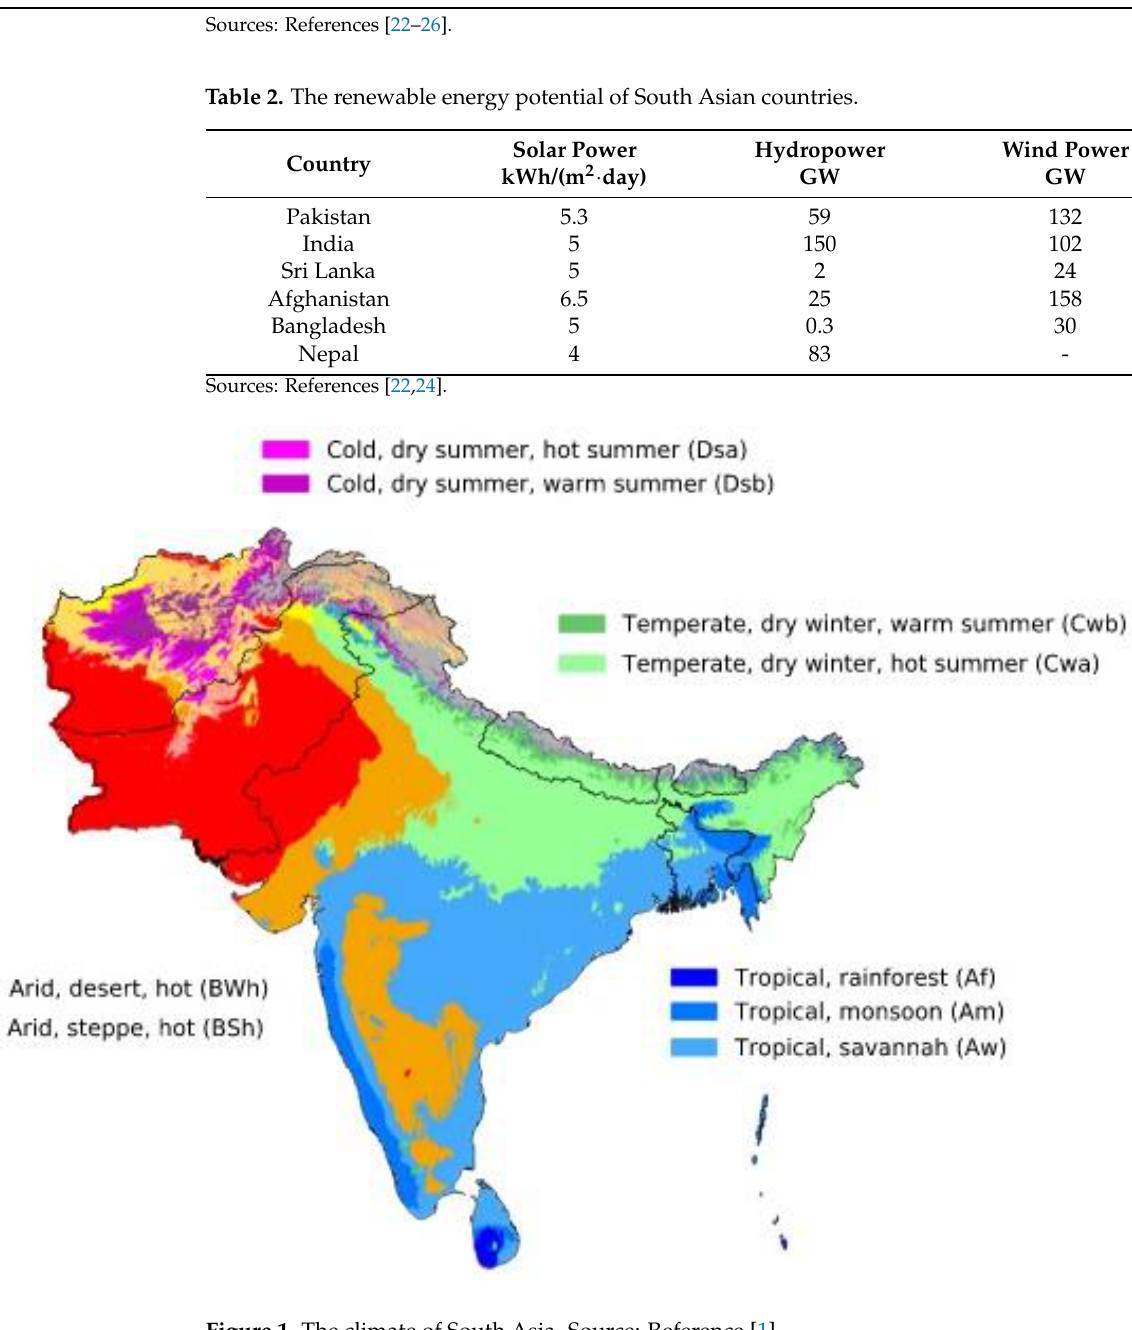
Table 2. The renewable energy potential of South Asian countries.